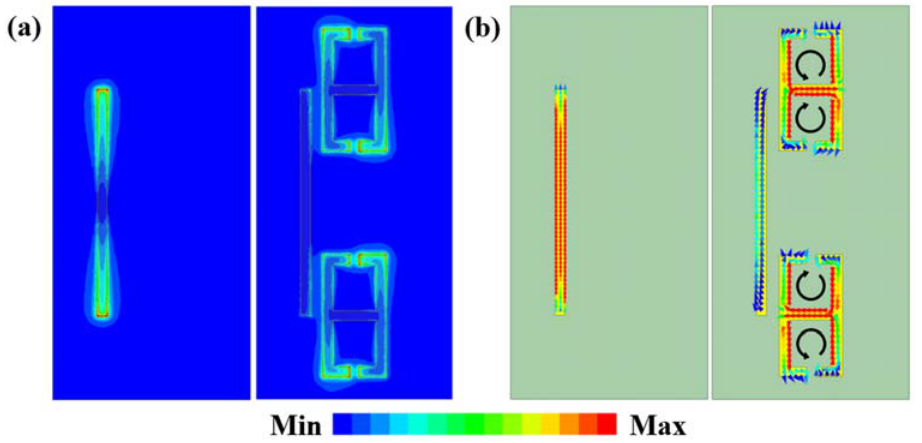
Figure 5. ( a ) Electric field distributions of the CW and EIT MTM at resonant frequency. ( b ) Surface current densities of the CW and EIT MTM at resonant frequency. The black arrow shows the direction of the induced current.